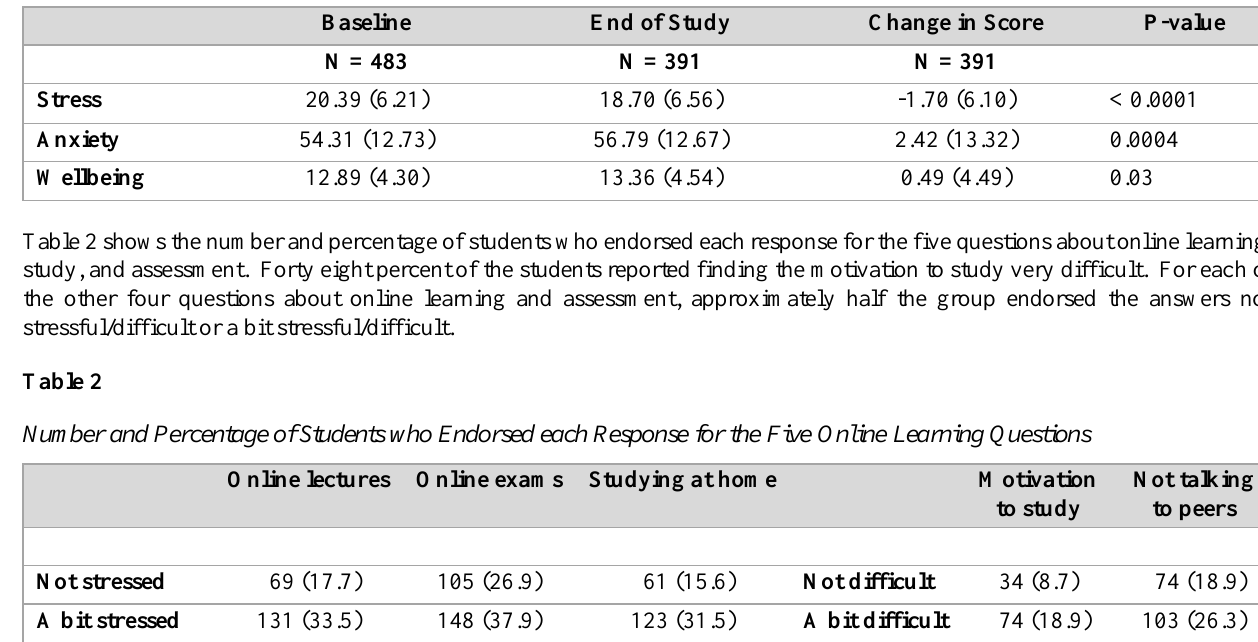
Mean (SD) Stress, Anxiety, and Psychological Wellbeing Scores at the Beginning and End of the Semester